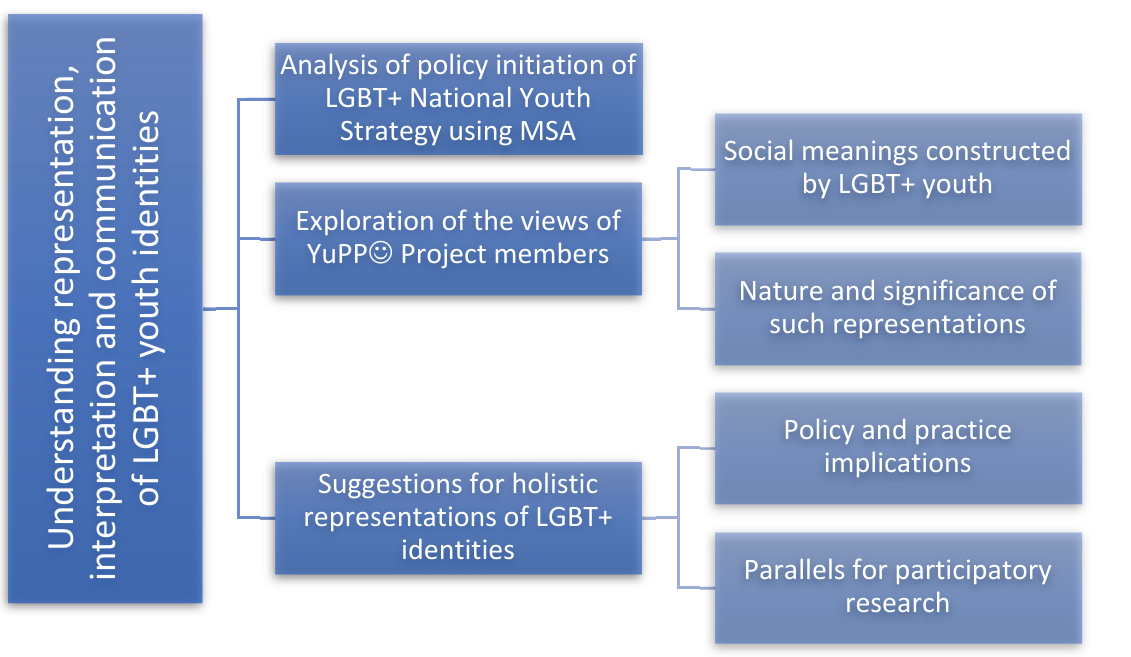
Figure 3. The study aims and objectives, aligned to concepts of recognitive justice.